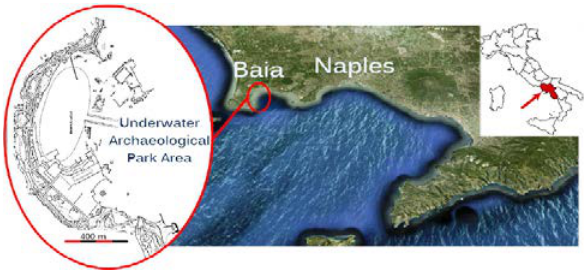
Figure 1. Geographical localization of underwater archeological site of Baiae